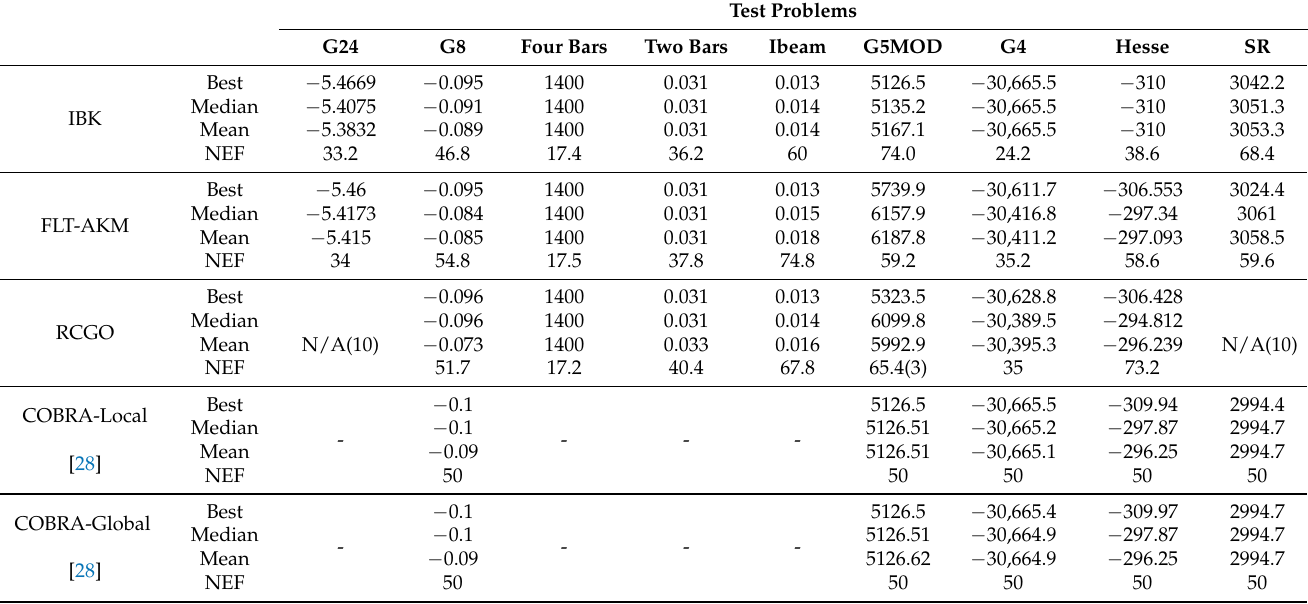
Figure 4. Optimization process-based infill strategy using IBK and FLT-AKM. Table 2. Comparison of the obtained results for the test